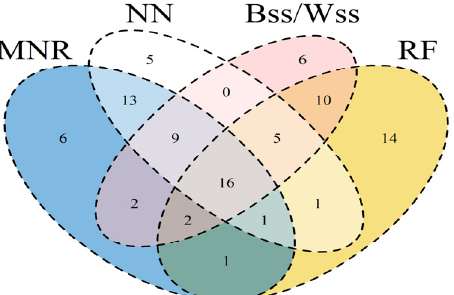
Figure 1. Venn diagram created using the R Limma package, displaying the level of overlap among different feature selection strategies based on variable importance assessed by means of Neural Network (NN), Multinomial Logistic Regression (MNR), Random Forest (RF) and the ratio of between-groups to within-groups sum of squares (BSS/WSS).